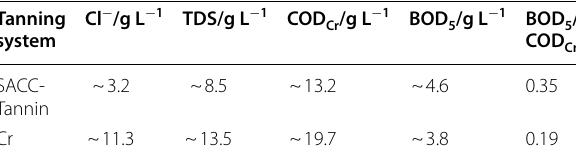
Table 3 Environmental assessment index of tanning spent liquor